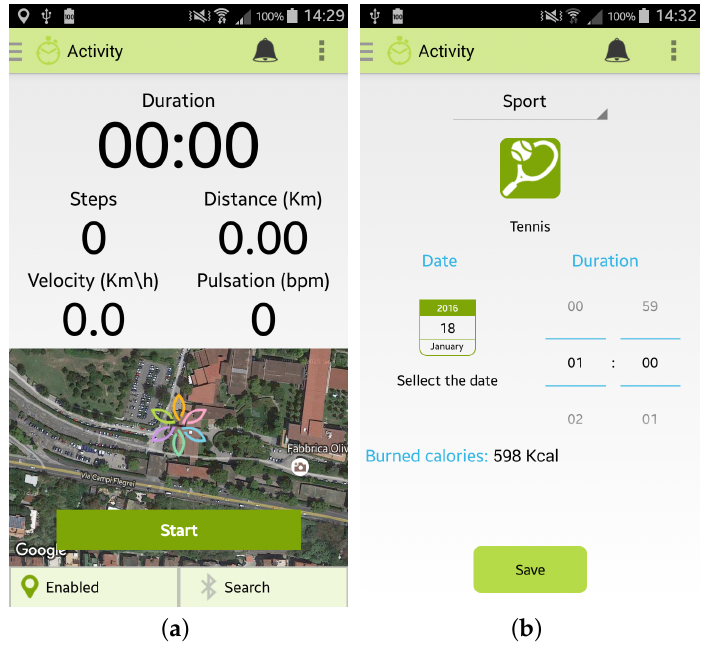
Figure 4. Screenshots of the Wellness App relating to physical activity: ( a ) Automatic insertion of a new activity; ( b ) Manual insertion of a new